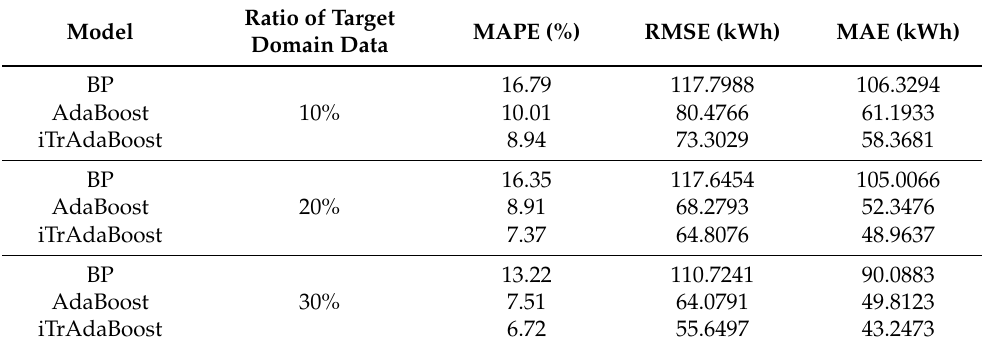
Table 2. Performance comparison of the three predictive models with different ratios of training data from target